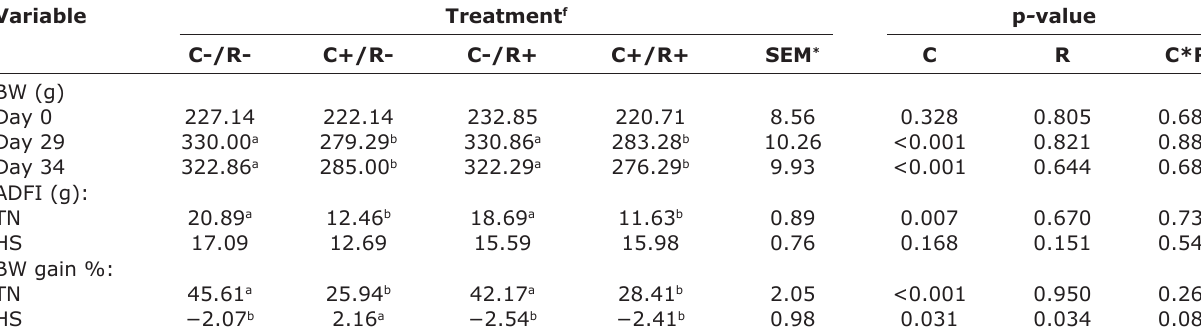
Table-3: BW, feed intake, and weight gain of HC rats treated with resveratrol under HS e .